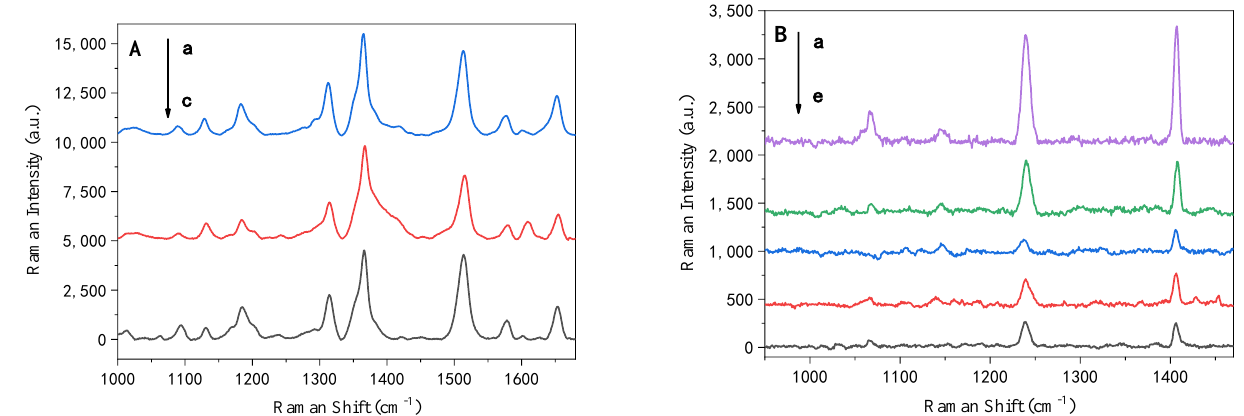
Figure 5. ( A ). SERS spectrum of R6G – ethanol solution with a concentration of 10 nM after dripping a volume of 10 µ L on the unmodified HRGB-SERS substrate for SERS detection. Spectra (a) to (c) represent 0, 7, and 31 days after the substrate preparation, respectively. ( B ). SERS spectrum of pyrene–ethanol solution with a concentration of 10 µ M after dropping a volume of 10 µ L on the modified HRGB-SERS substrate for SERS detection. Spectra (a) to (e) represent 0, 2, 4, 8, and 10 days after the substrate preparation, respectively. Laser power: 13.8 MW; integration time: 1 s × 1; objective lens: 20 × .